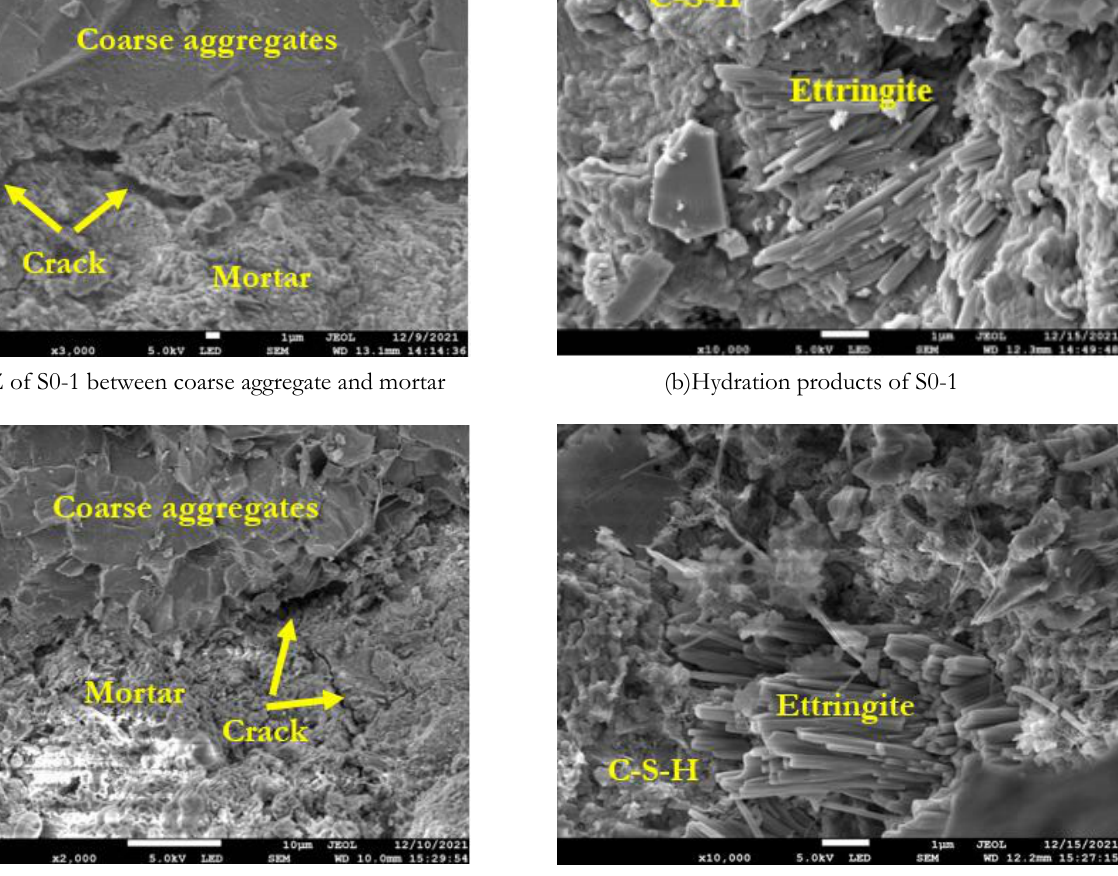
Figure 8: SEM images of S0-1 and